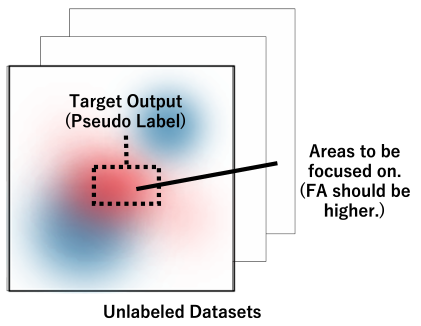
Figure 4. Conceptual diagram of the method for the data selection. The background image illustrates the saliency map of